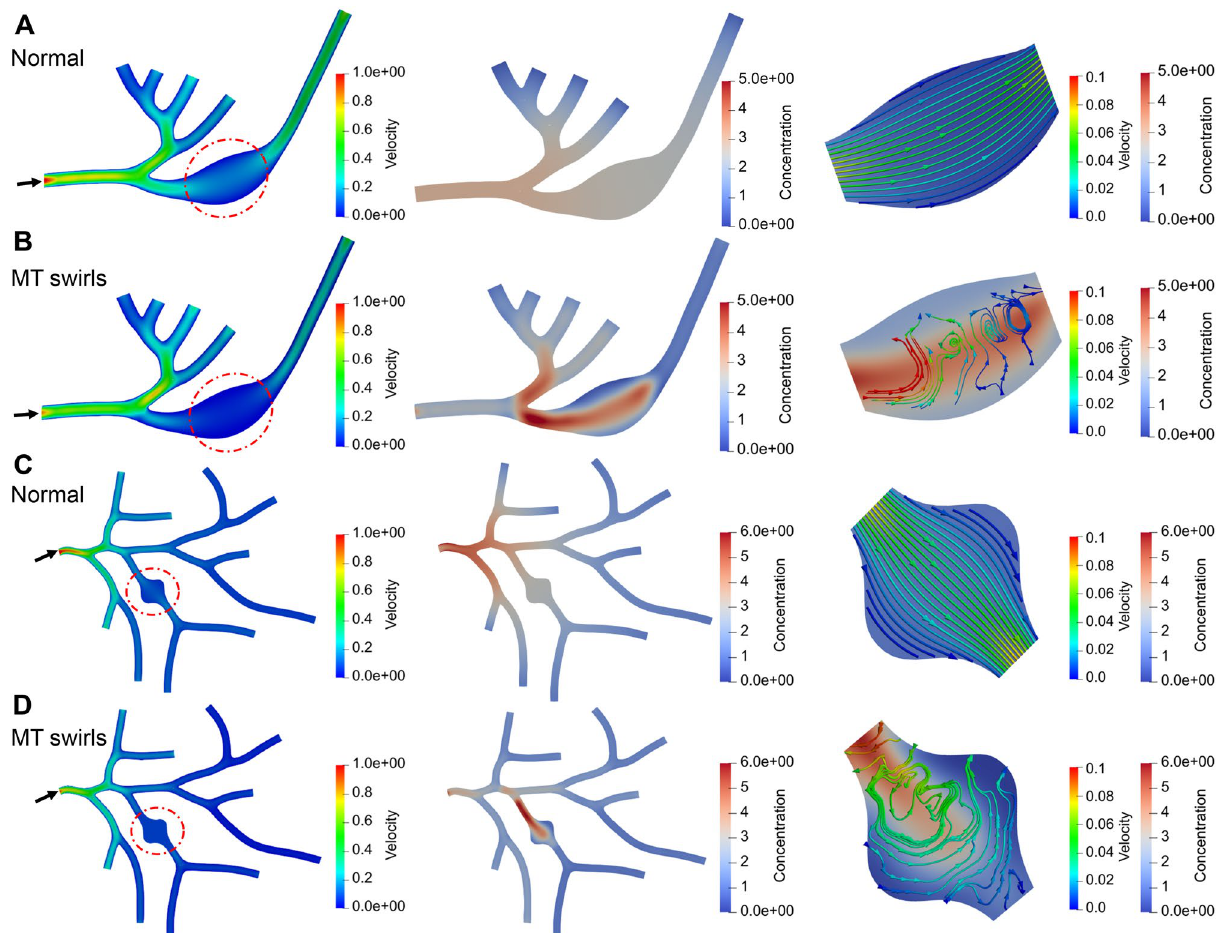
Figure 6. Simulation of material transport in neuron trees extracted from ( A , B ) NMO_54504 and ( C , D ) NMO_54499 with swelling in the red circle regions. The first column shows the computed velocity field and black arrow points to the inlet of the material. The second column shows the concentration distribution. The last column shows the velocity streamline and concentration distribution in the swollen region. Different color maps are used to distinguish between velocity and concentration. Unit for color bars: Concentration: mol/ µ m Velocity: µ